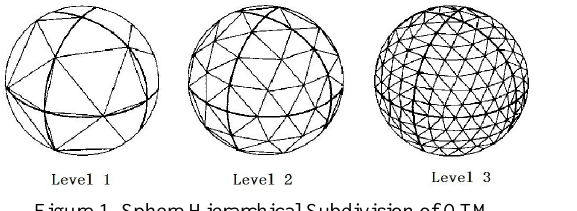
Figure 1. Sphere Hierarchical Subdivision of QTM